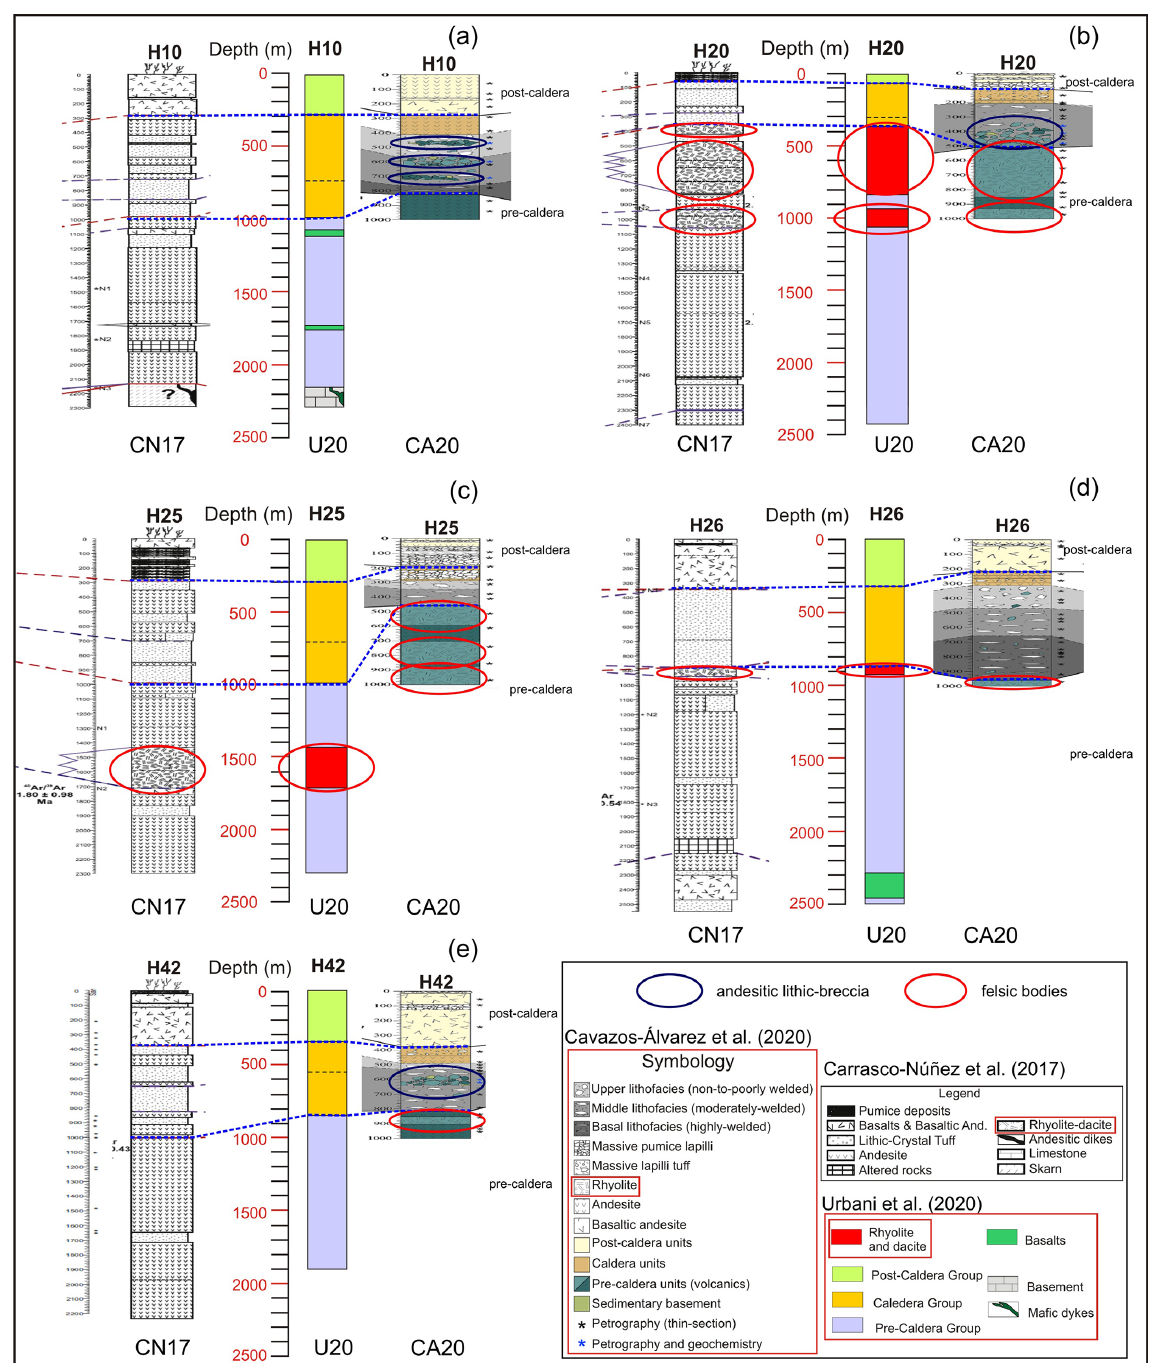
Figure 3. Lithostratigraphic columns of the wells (a) H10, (b) H20, (c) H25, (d) H26 and (e) H42 as proposed by Carrasco-Núñez et al. (2017b; CN17 in figure), Urbani et al. (2020; U20 in figure) and Cavazos-Álvarez et al. (2020; CA20 in figure). Felsic or rhyolitic bodies within the volcanic sequence are indicated by red ellipses, whereas the newly identified andesitic lithic breccias within the intracaldera Xaltipan ignimbrite deposits (Cavazos-Álvarez et al., 2020) are indicated by blue ellipses.